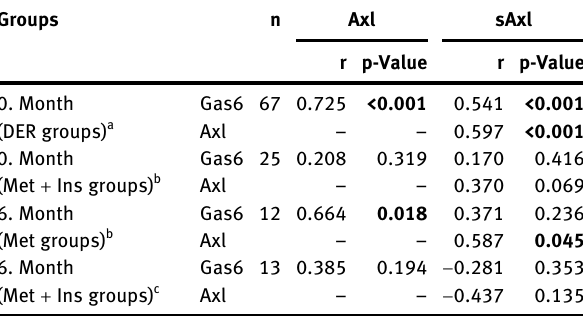
Table  : Correlations of Gas  , Axl, and sAxl parameters according to antidiabetic drug use